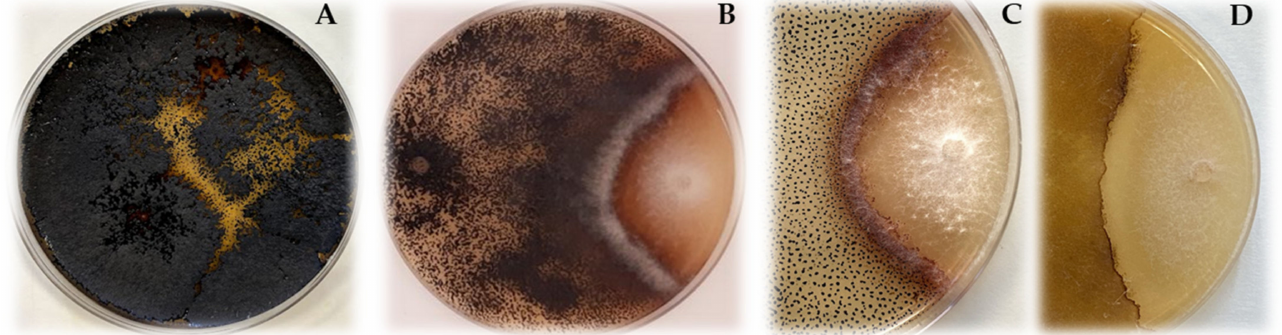
Figure 2. ( A ). Microsclerotia formed by DSE Rutstroemia calopus . ( B ). Inhibitory effect of DSE R. calopus against F. solani on PDA medium. Effect of salt stress ( C ): PDA amended with 5 g · L − 1 of NaCl; ( D ): PDA amended with 20 g · L − 1 of NaCl) on microbial antagonism of R. calopus against Sclerotinia sclerotiorum . High salt concentrations significantly reduced the number of microsclerotia and melanin accumulation. No reduction in the antagonistic effect of DSE was